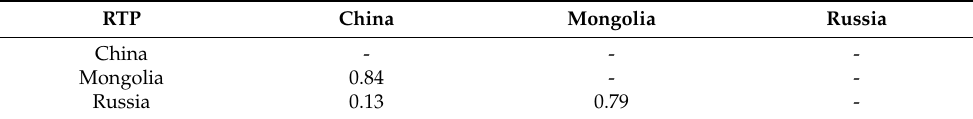
Table 3. RTP index for countries in the China–Mongolia–Russia Economic Corridor